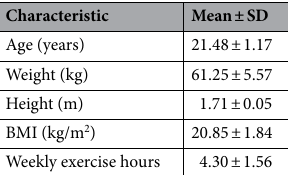
Table 1. Demographic information of participants (N = 21 male subjects). SD, standard deviation. BMI, body mass index.